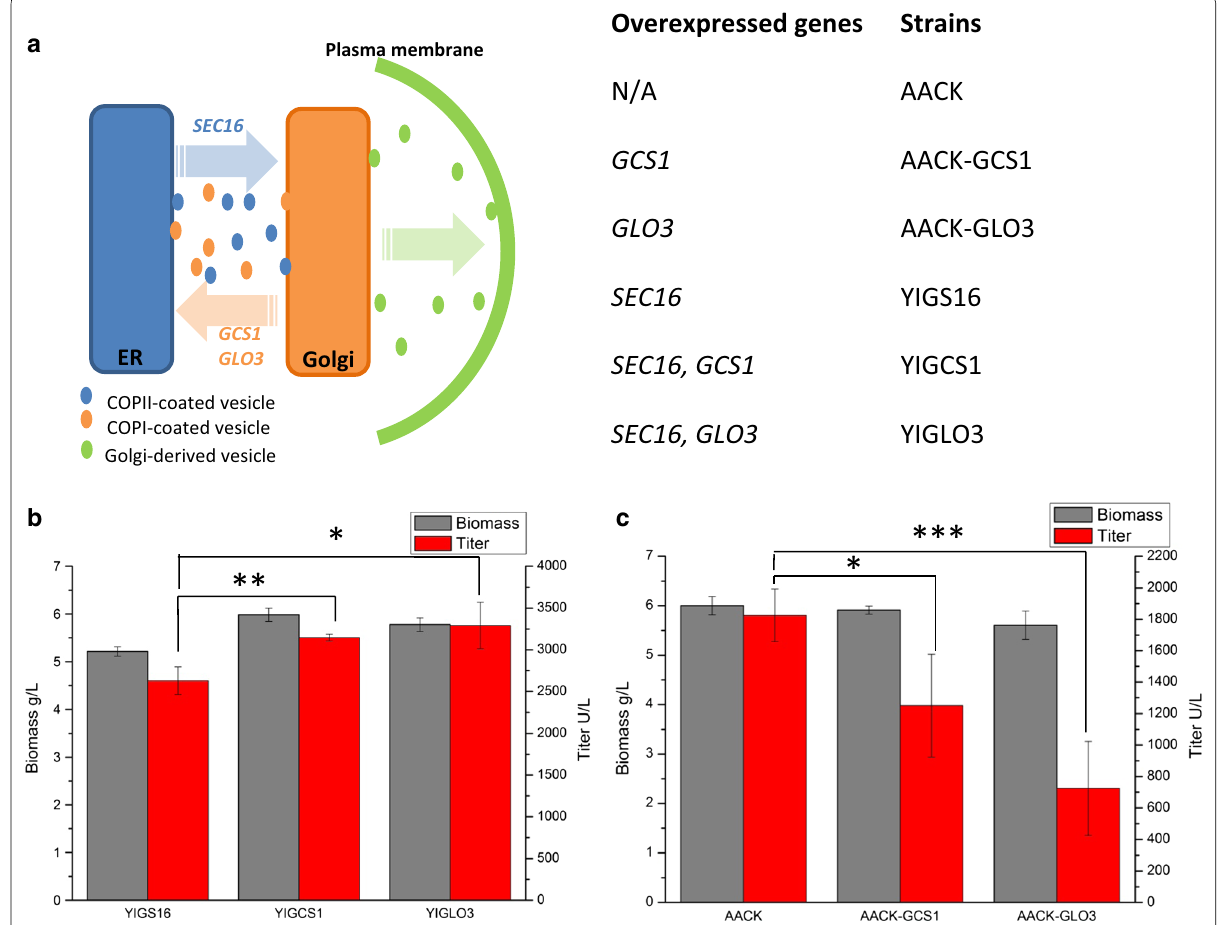
Fig. 1 Overexpression of GCS1 or GLO3 by promoter replacement in the SEC16 -overexpression strain (YIGS16) has a positive effect on α-amylase secretion. a Constructions of the vesicle trafficking engineering strains. SEC16 is involved in COPII vesicle formation; GCS1 and GLO3 are involved in COPI vesicle formation. b The titer and biomass of YIGS16, YIGCS1 and YIGLO3. c The titer and biomass of AACK, AACK-GCS1 and AACK-GLO3. *P < 0.05; **P < 0.01; ***P < 0.001. Measurements are reported as the average value standard deviation from independent ±